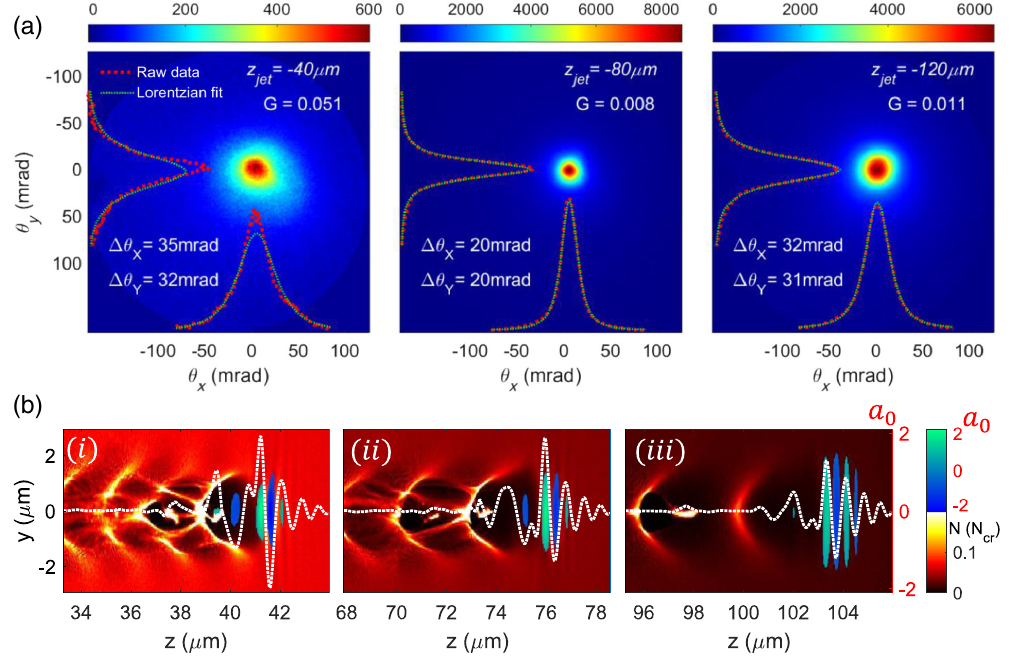
0 . 08 , ð P=P ∼ 2 . =N e; peak cr ¼ cr Þ max ) relative to the laser beam jet